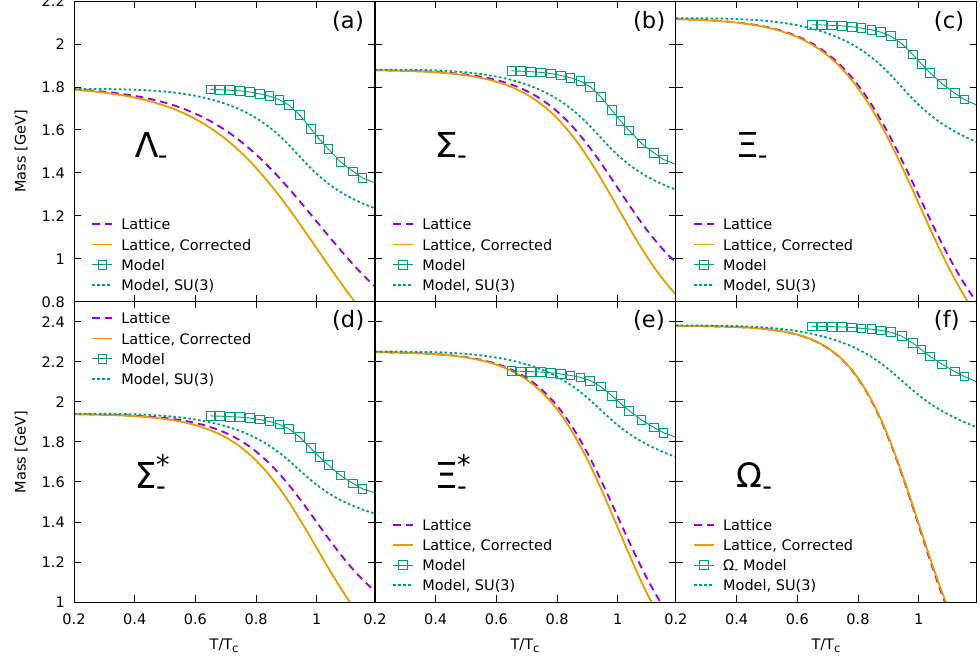
Figure 2. Temperature dependence of the strange baryons with negative parity for ∆ − , for the Assignment C in Table